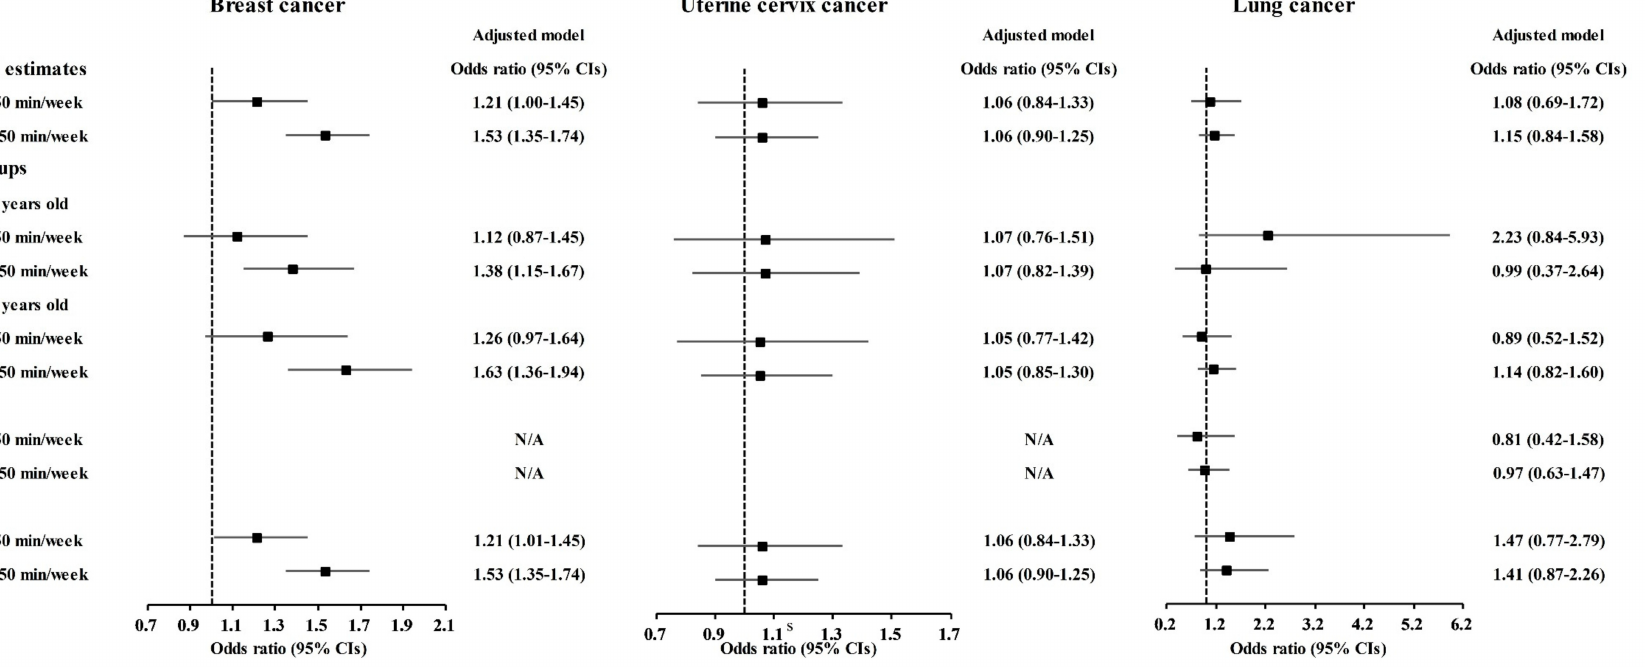
Figure 6. Odds ratios of physical exercise for breast cancer, uterine cervix cancer, and lung cancer histories according to age and